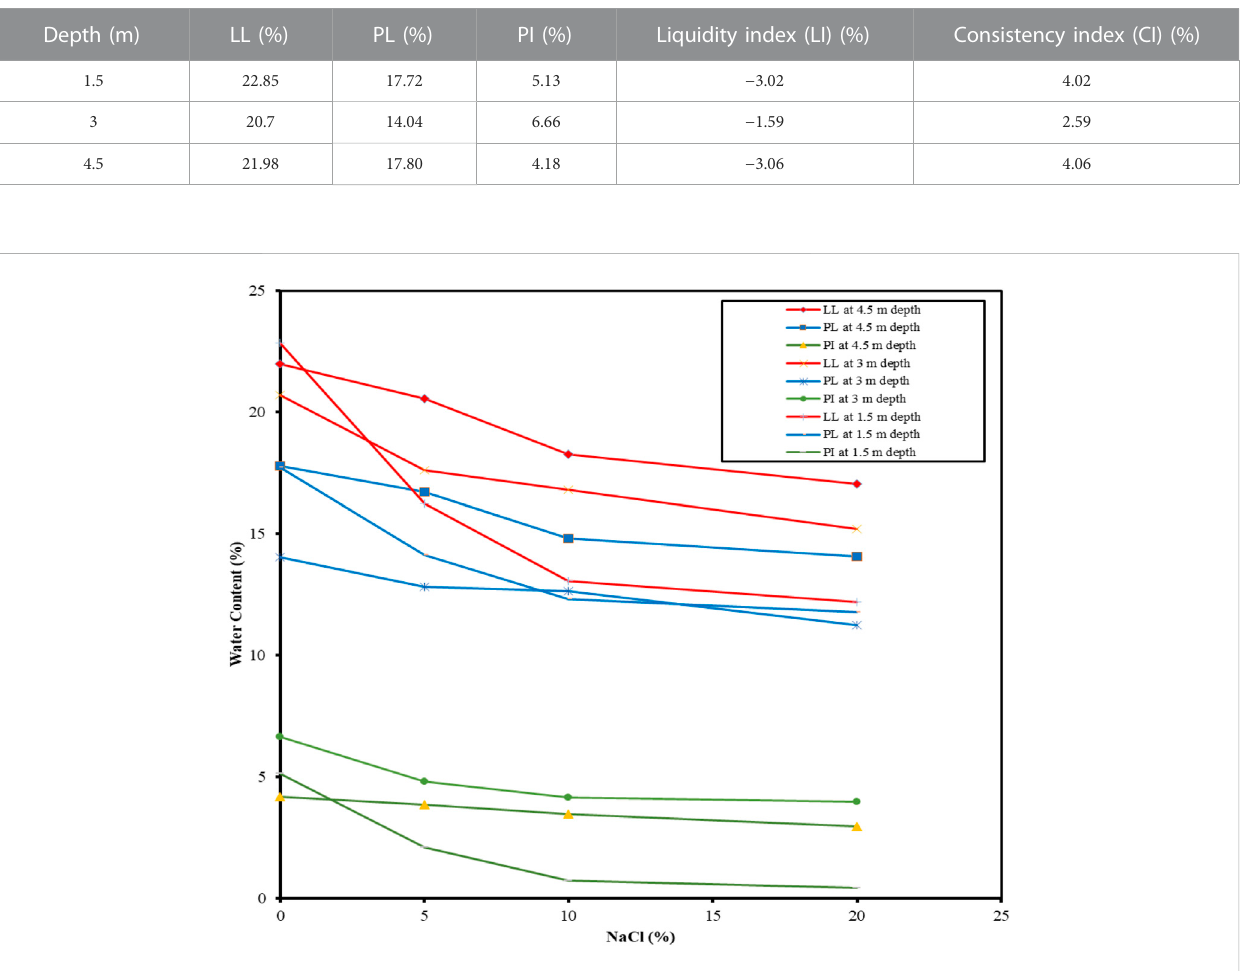
FIGURE 4 Effect of different NaCl percentages on Atterberg limits of soil at different